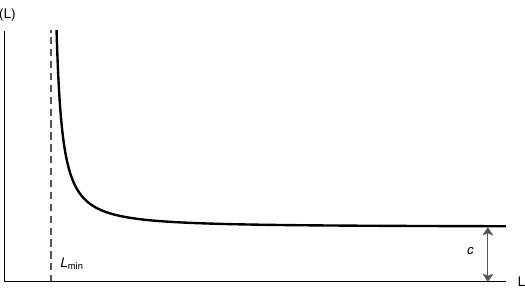
Figure 6 . c ( L ) vs. L plot for the case c 1 = 0 . The c -function is independent of the UV cutoff of the theory. To generate this plot we have chosen ε ± to be of the form ε + = 0 . 35 The location and pole and its residue as can easily be read off from (3.34) matches exactly with the